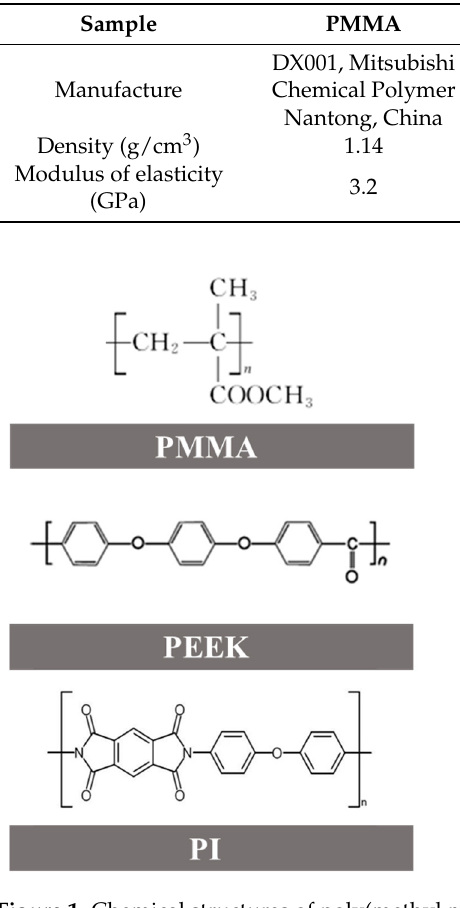
Table 1. Mechanical properties of polymers used in this work.